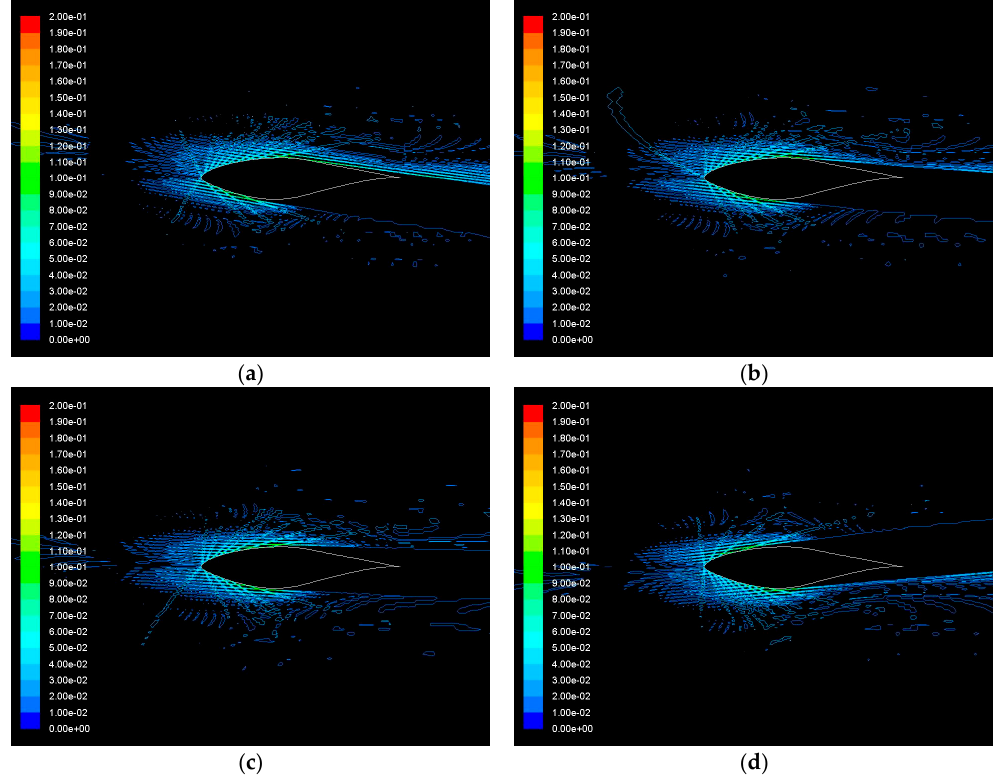
Figure 13. Contours of DPM concentration at ( a ) − 3°; ( b ) 0°; ( c ) 3°; and ( d ) 9° angles of attack at Re = 1 × 10 6 with the realizable k– ε turbulence model for an S809 airfoil for air-sand particle two-phase flow and 1% concentration of sand particles in the air.